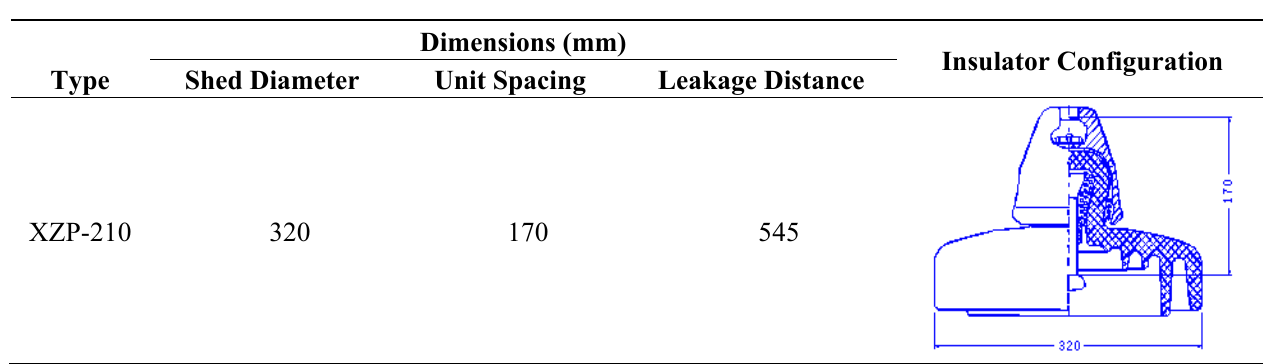
Table 1. Profile Parameters of a Porcelain